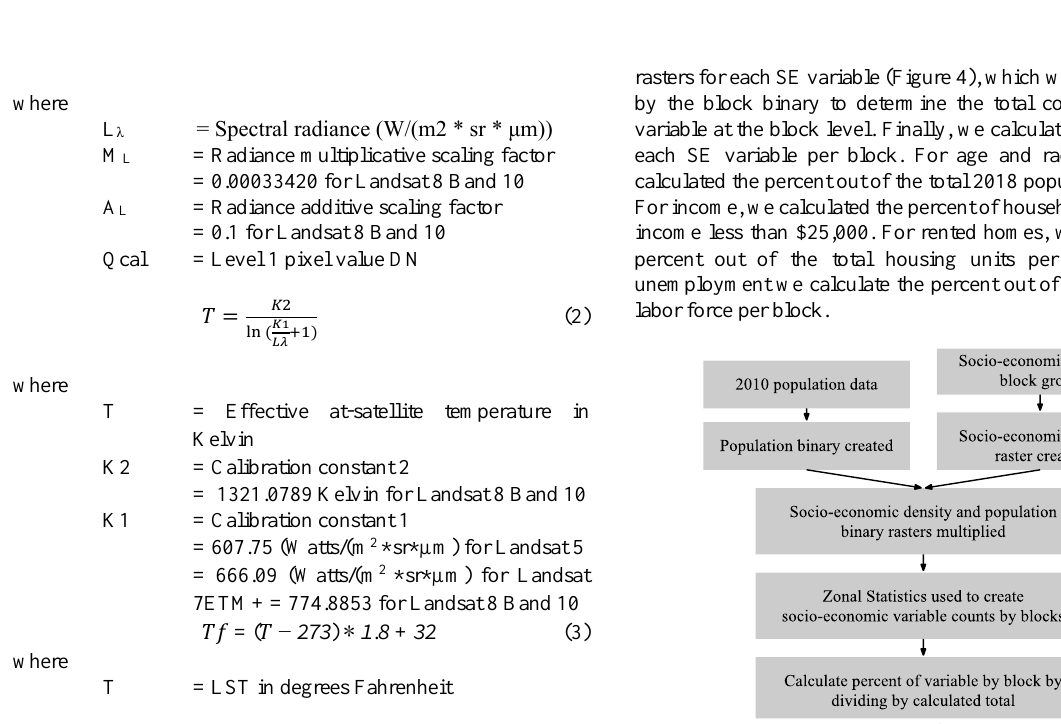
Figure 3. Dasymetric approach for mapping percent of socio- economic variables